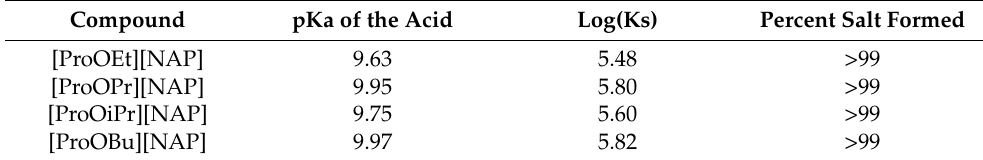
Table 3. Predicted degree of salts formation for L-proline alkyl ester naproxenates [ProOR][NAP].